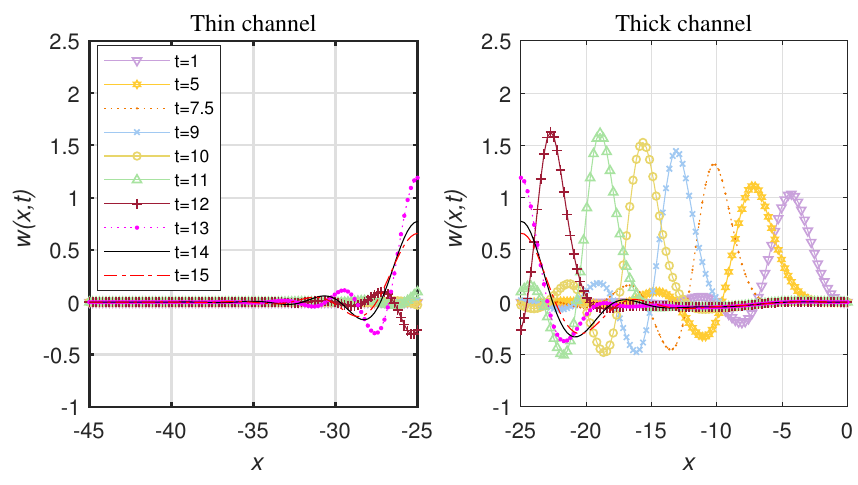
Figure 4. The solution from t = 1 to t = 15.